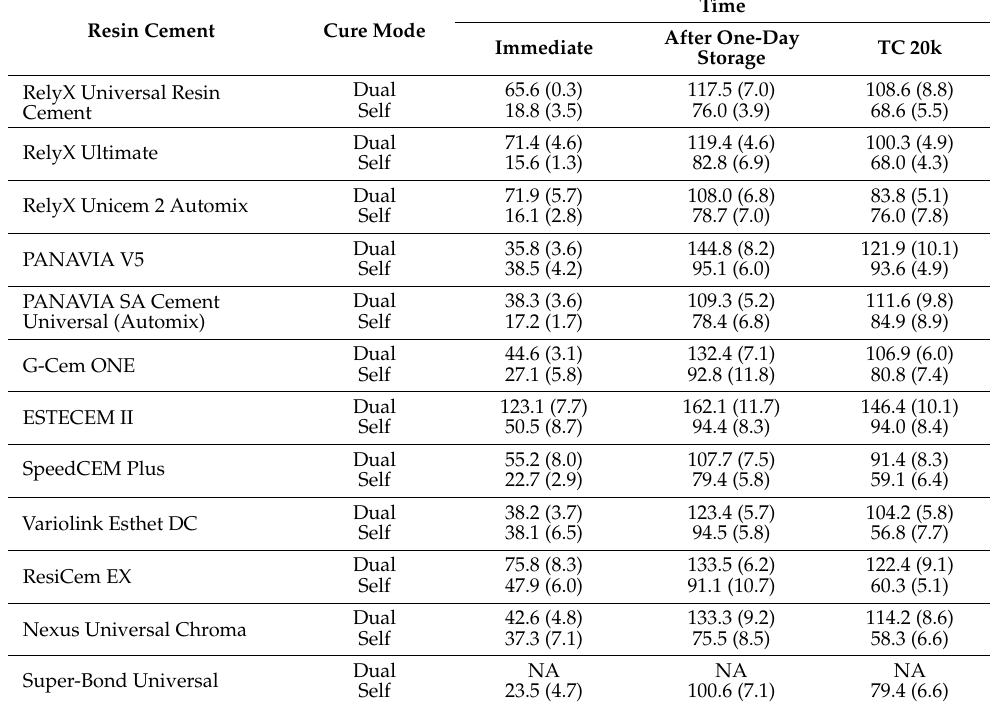
Table 7. Flexural strength of resin cements [MPa, mean (S.D.)].